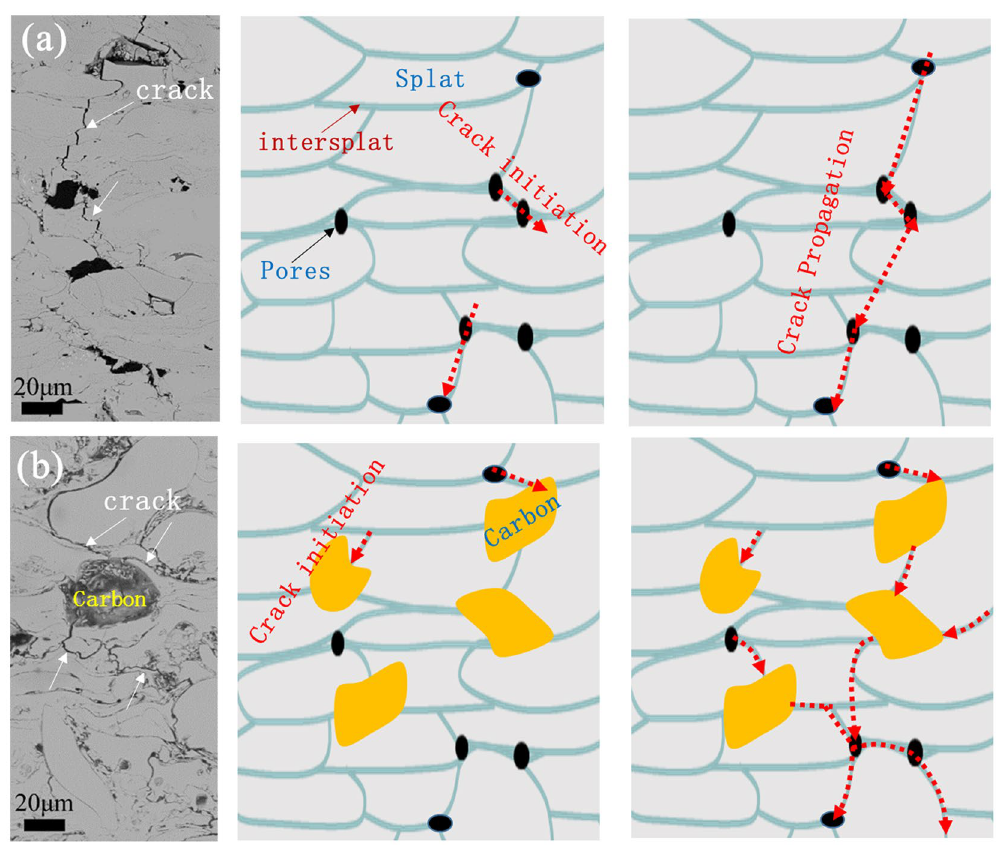
Figure 10. SEM fracturing morphologies after fatigue tests and schematic diagrams depicting the cracking behaviors ( a ) the amorphous coating and ( b ) the composite coating with carbon. In amorphous coating, the crack propagates through the pores or defects and easily penetrates the whole coating. But in composite coating, the crack propagation could be hindered by ductile carbon particles, which is therefore difficult for developing through-wall crack in the whole